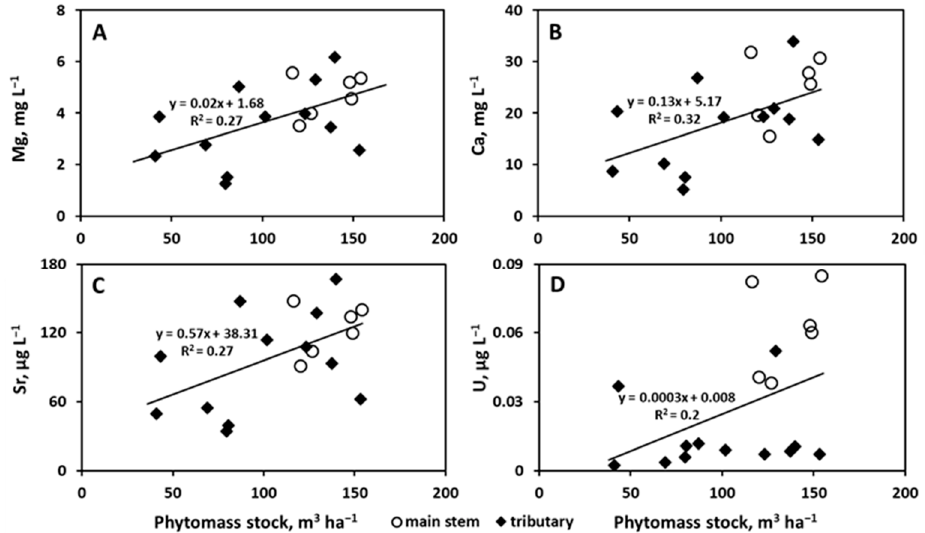
Figure 5. Example of positive correlations between Mg ( A ), Ca ( B ), Sr ( C ), and U ( D ) and landscape factors of the Ket River in summer. factors of the Ket River in